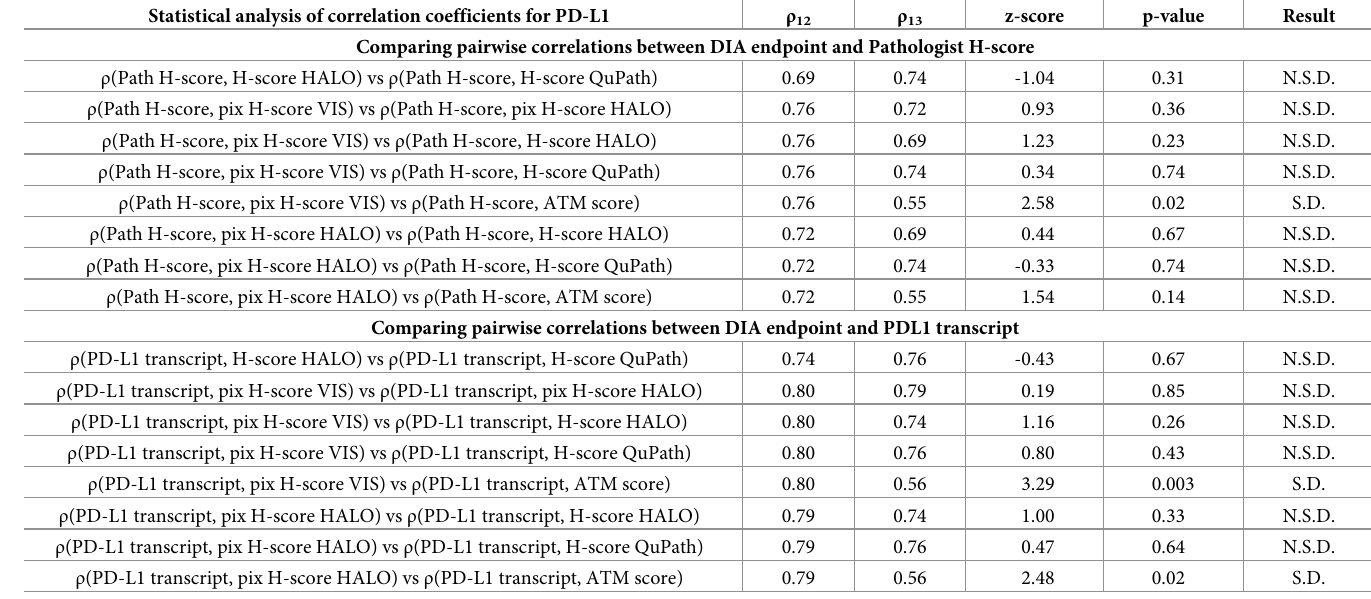
Table 2. Table lists the results of William’s t-test to test for significant difference in the Spearman correlation coefficients between PD-L1 mRNA transcript or pathologist H-score and different DIA endpoints. Statistical analysis of correlation coefficients for PD-L1 Comparing pairwise correlations between DIA endpoint and Pathologist H-score